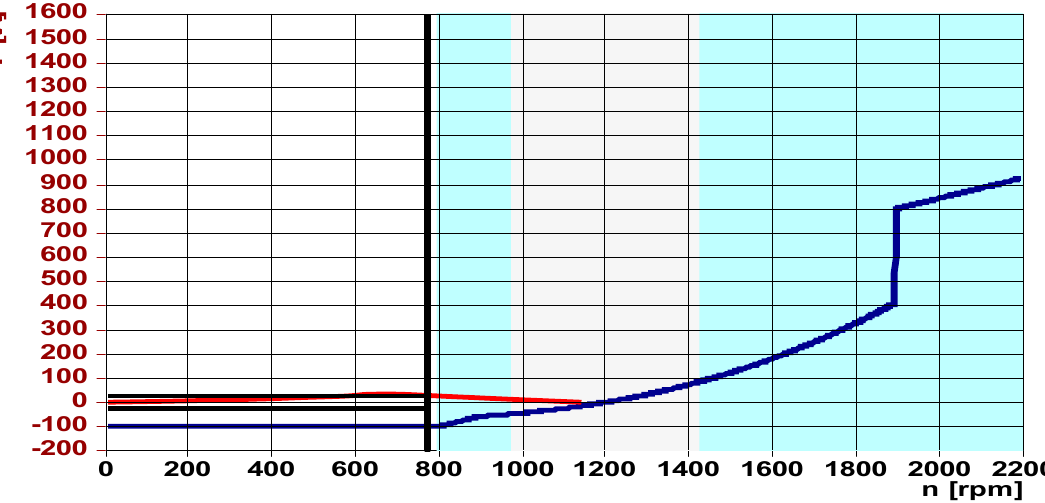
Figure 19. A wind turbine based on DFIG with a speed of 4.5 m/s.